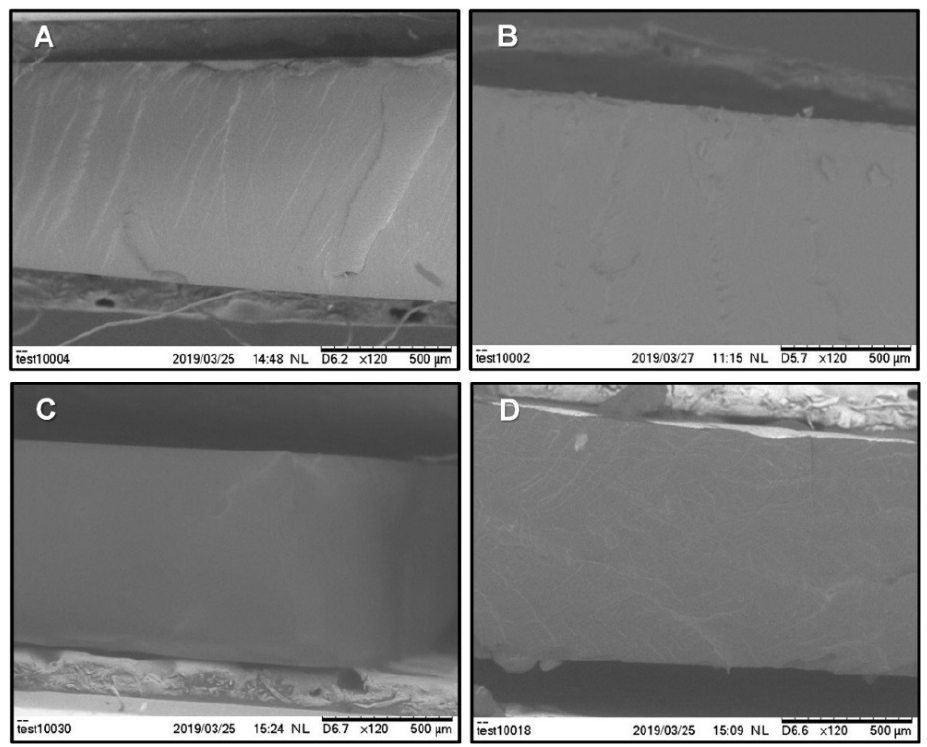
Figure 6. SEM micrographs of fracture cross-section of the iongels containing 80 wt % of the selected ILs: ( A ) [C 2 mim][FSI], ( B ) [C 2 mim][TFSI], ( C ) [C 2 mim][C(CN) 3 ] and ( D ) [C 2 mim][B(CN) 4 ].